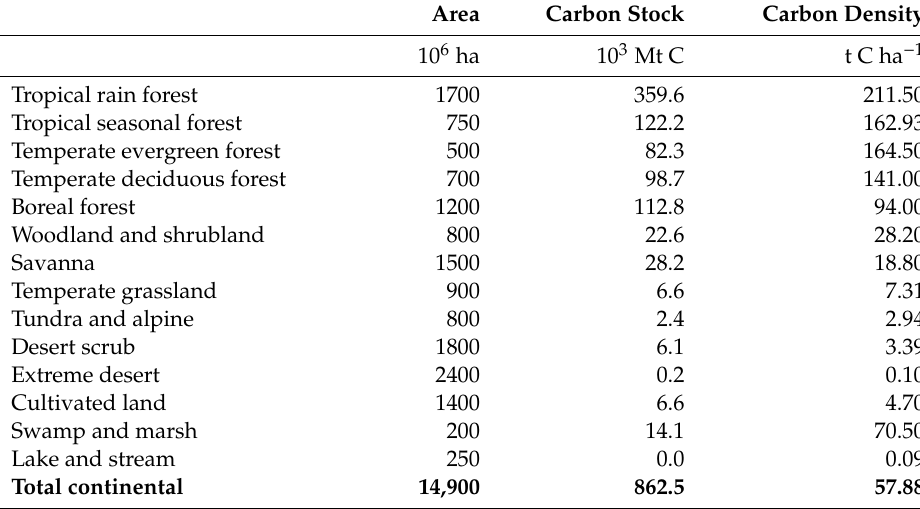
Table 1. The areas, carbon stocks and mean carbon densities of major biome types